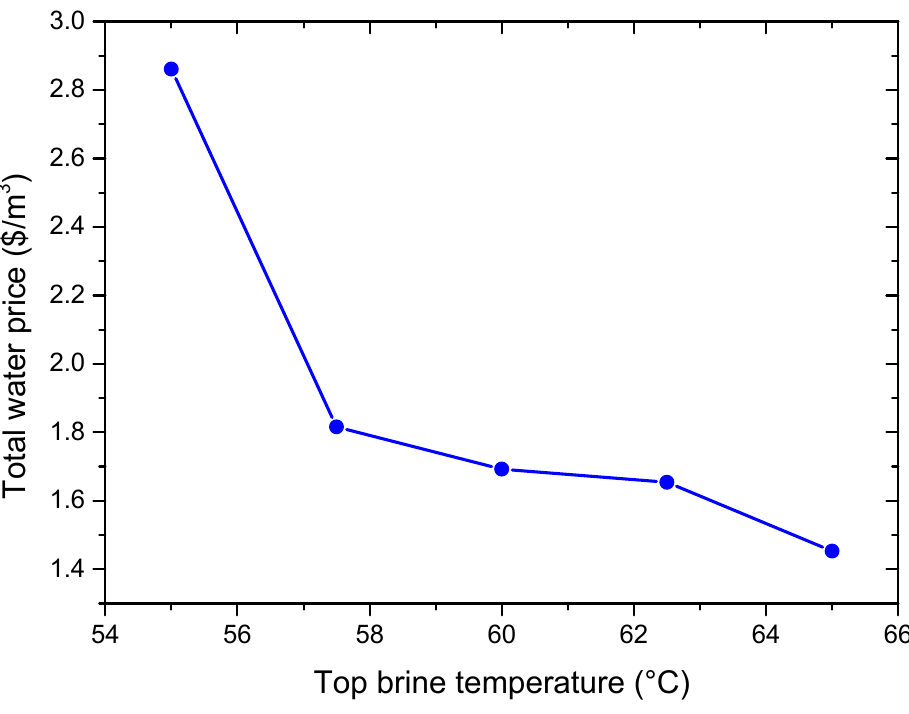
Figure 4. Effect of top brine temperature on the TWP.